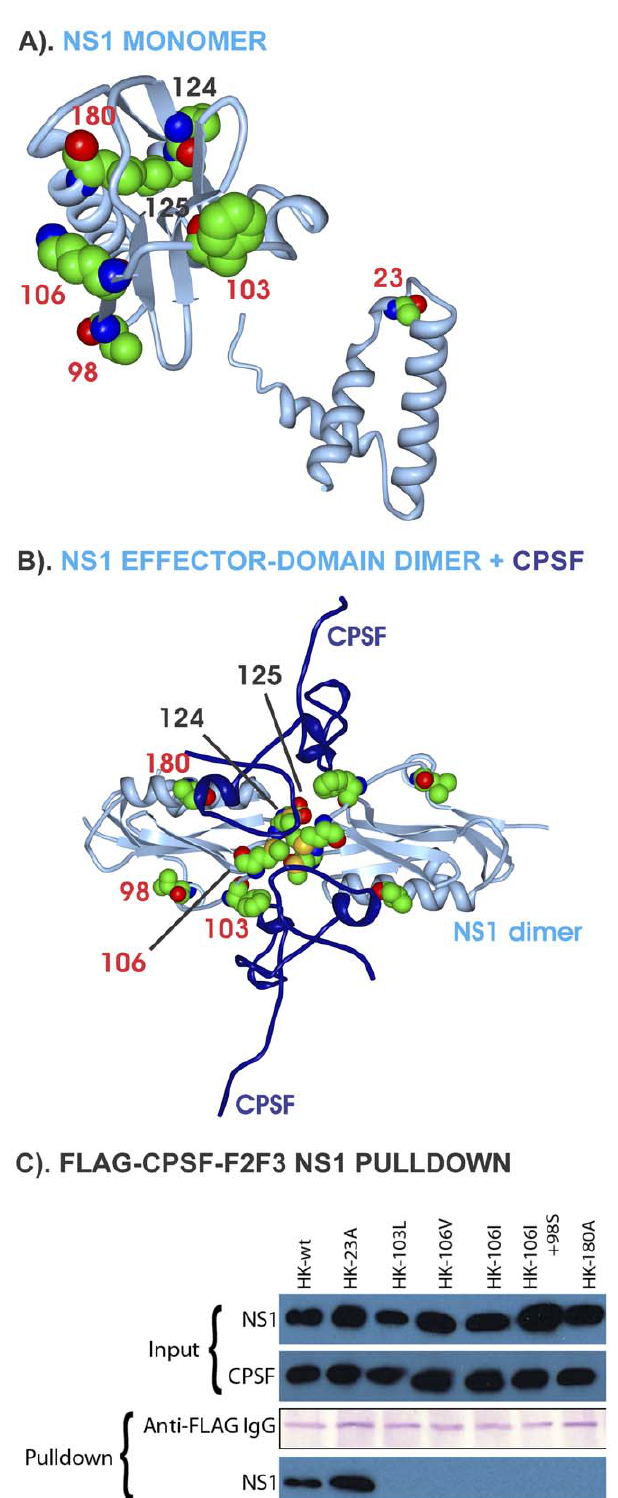
Figure 10. NS1 three dimensional maps of mouse adaptive mutations and effects on CPSF binding. Mutations are shown as numbered space filling images as described in Fig. 3. (A) in the NS1 monomer; (B) the NS1 dimer effector domain (grey) bound to 2 CPSF F2F3 fragments (dark blue). Amino acid NS1 106 of each monomer is in direct contact in the dimer. CPSF30-F2F3 is in direct contact with NS1 amino acids 103, 106 and 180. (C) Coimmunoprecipitation of HK-wt